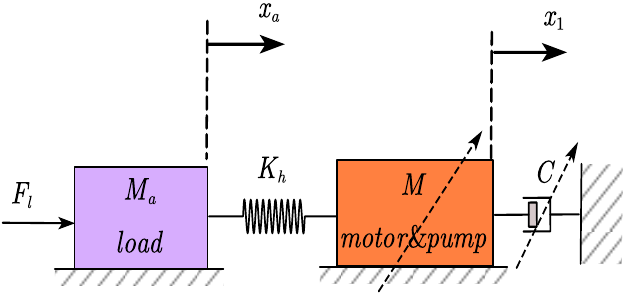
Figure 10. ALS-EHA simplified free-body diagram.